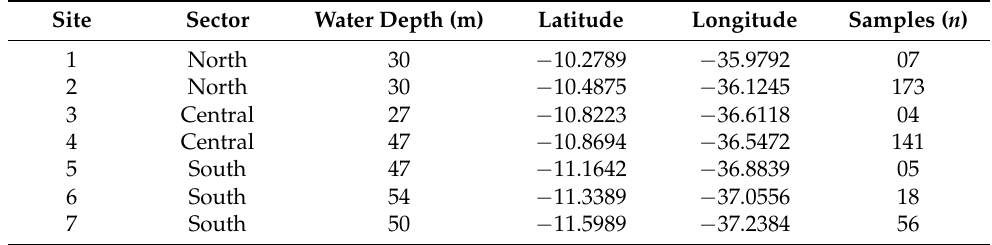
Table 1. Sampling site locations, water depth and number ( n = 404) of samples collected and analyzed in the present study. Coordinates are in SIRGAS 2000